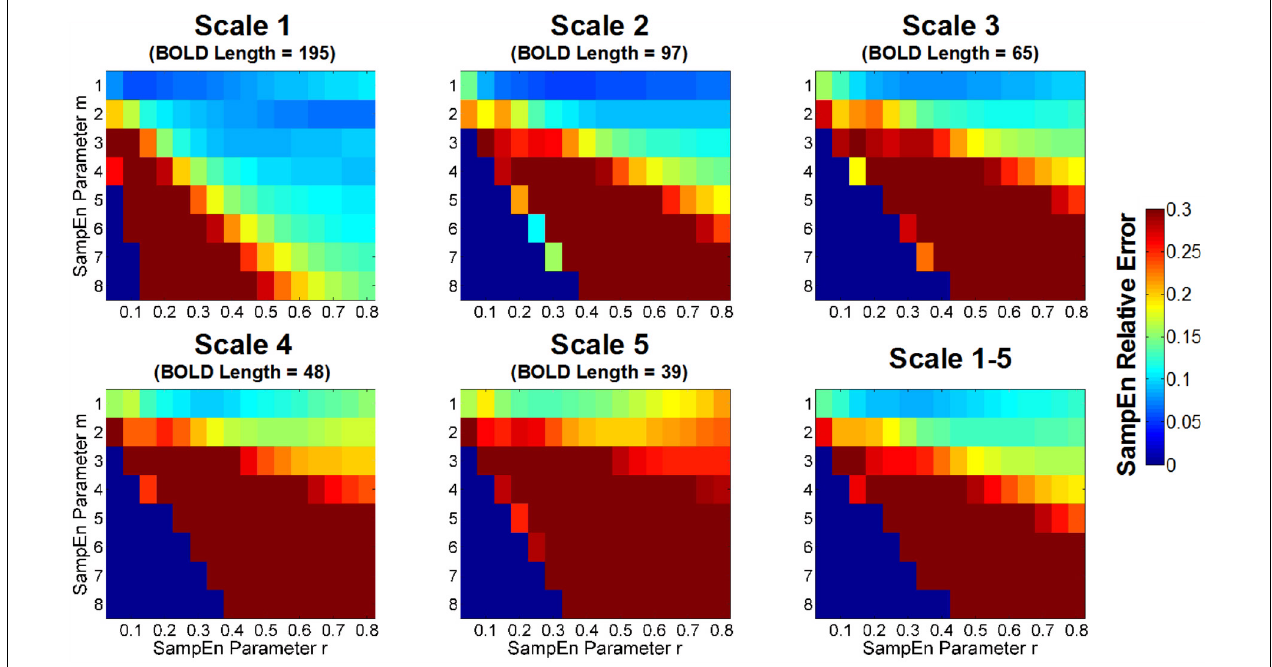
FIGURE 4 | Color map of the relative error of sample entropy (SampEn) of CSF BOLD data for appropriate selection of m and r . The SampEn relative error was defined in accordance with Lake et al. (2002) based on the 95% CI relative to the average SampEn in all CSF voxels; thus, the metric indicated the consistency of the SampEn calculation. A lower SampEn relative error indicated a higher consistency of SampEn. For example, a SampEn relative error value of 0.05 corresponds to a 95% CI, which is 10% of the average SampEn estimate. In this study, the goal was to minimize the relative error of SampEn in CSF BOLD signals because they exhibit characteristics of uncorrelated randomness and contain minimal physiologic information. The median value of the SampEn relative error for the entire study cohort is shown in color with various combinations of m , r , and scale factors.